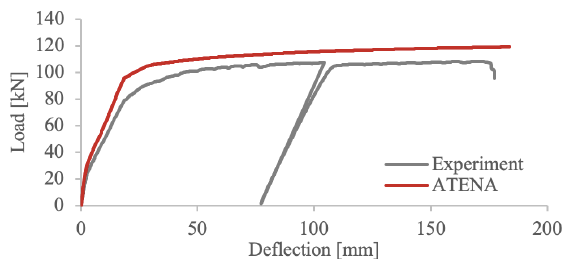
Figure 6. The experimental loading curve of strengthened panels compared with the ATENA sim- ulation with material parameters based on the prior calibration